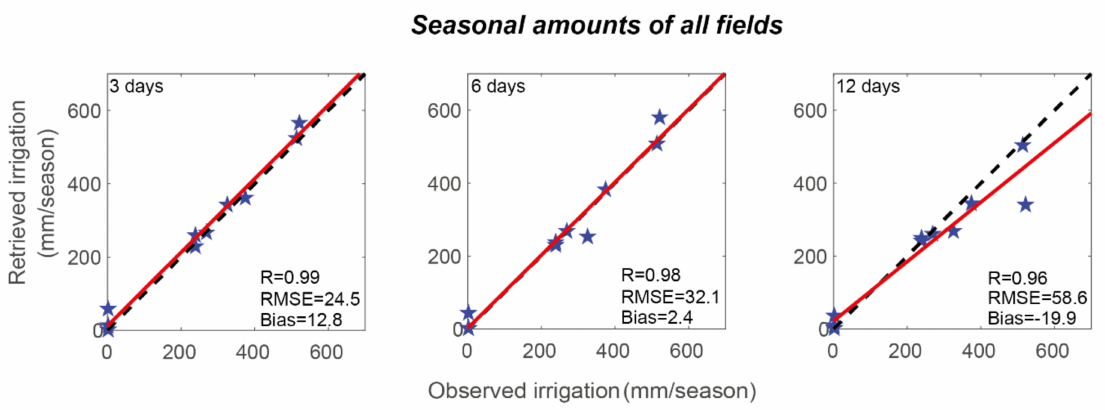
Figure 5. Retrieved seasonal sum of irrigation versus observed seasonal sum of all the studied fields and seasons for the three window